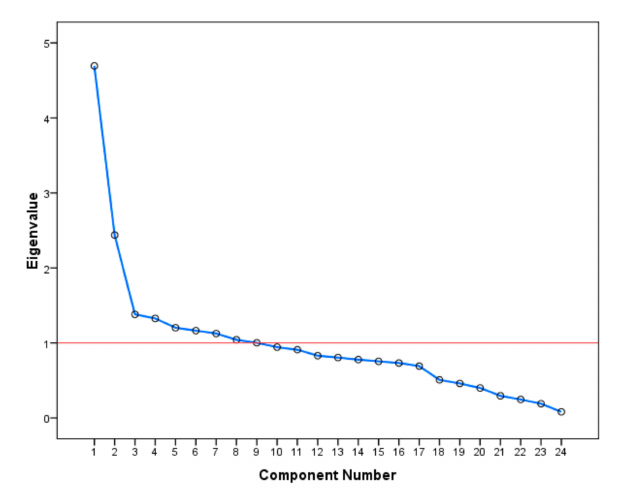
Figure 3. Eigenvalues for all components considered (scree plot).